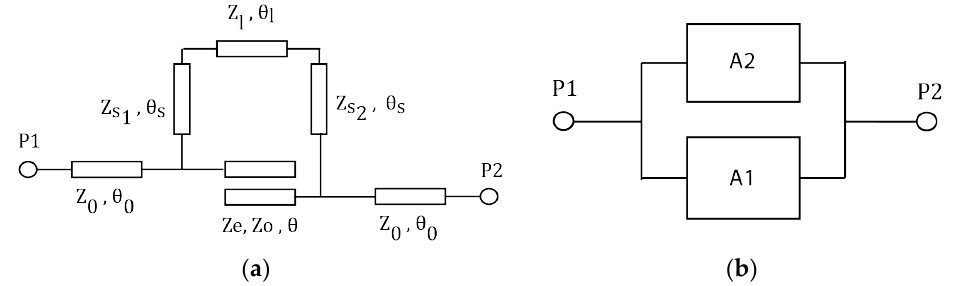
Figure 7. ( a ) Ideal bandstop filter. ( b ) Matrix representation of the bandstop filter.